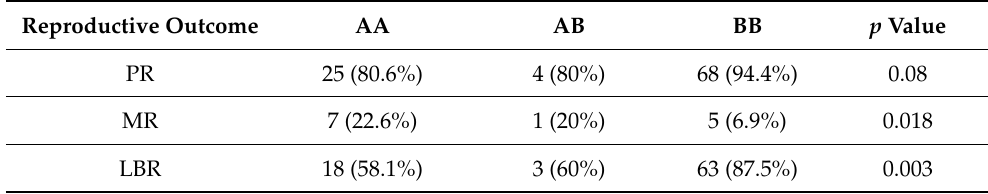
Table 4. Comparison of reproductive outcomes between patients with various haplotypes. Reproductive